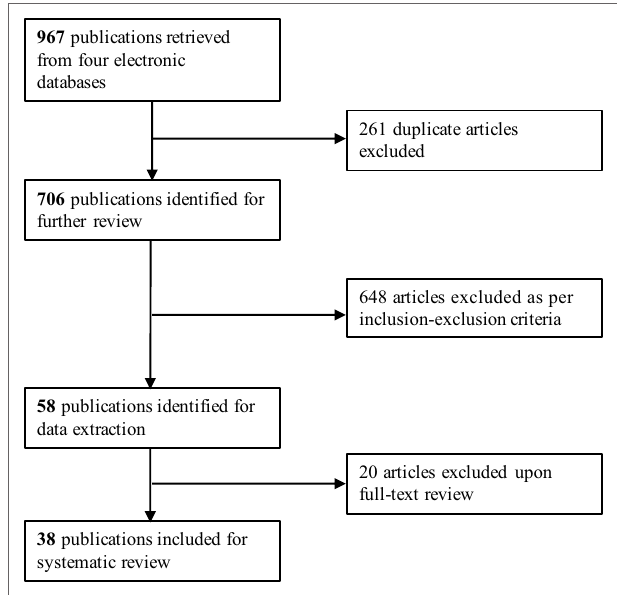
FigURe 1 | Flow chart of literature selection for systematic review. The vertical arrows indicate inclusion, and the horizontal arrows indicate